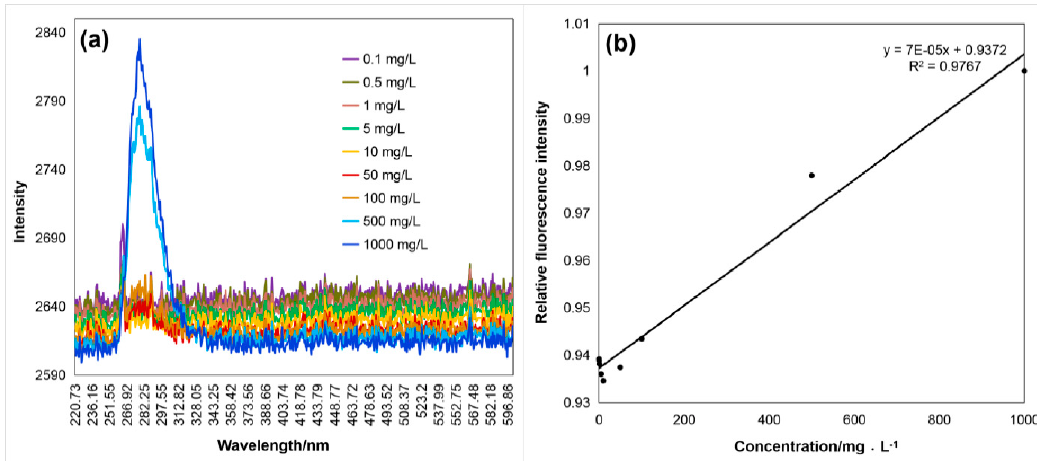
concentration, C 2 , of 5 ug/L–1 g/L with a coefficient of determination of 0.9952.